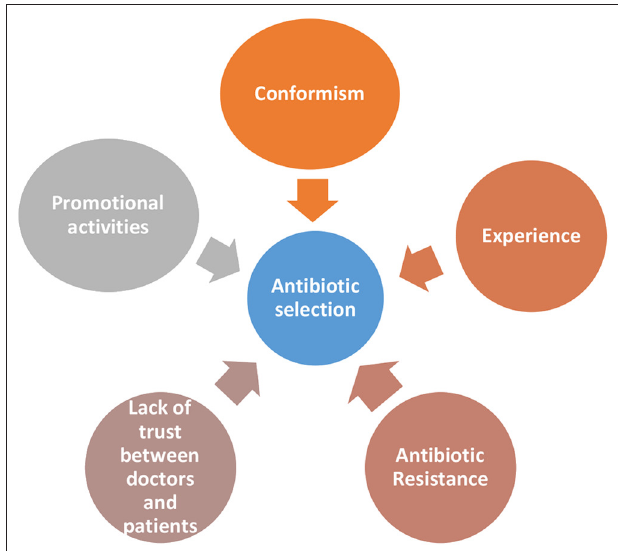
FIGURE 2 | Factors guiding antibiotic